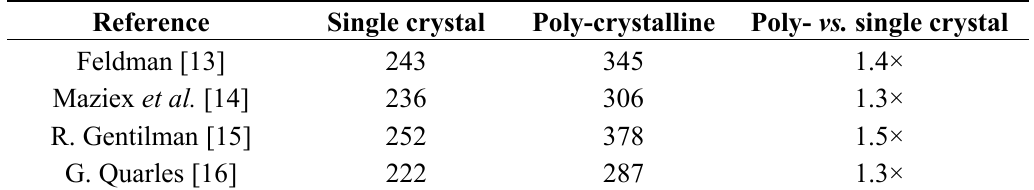
Table 4. Strength of ceramics compared with single crystals.